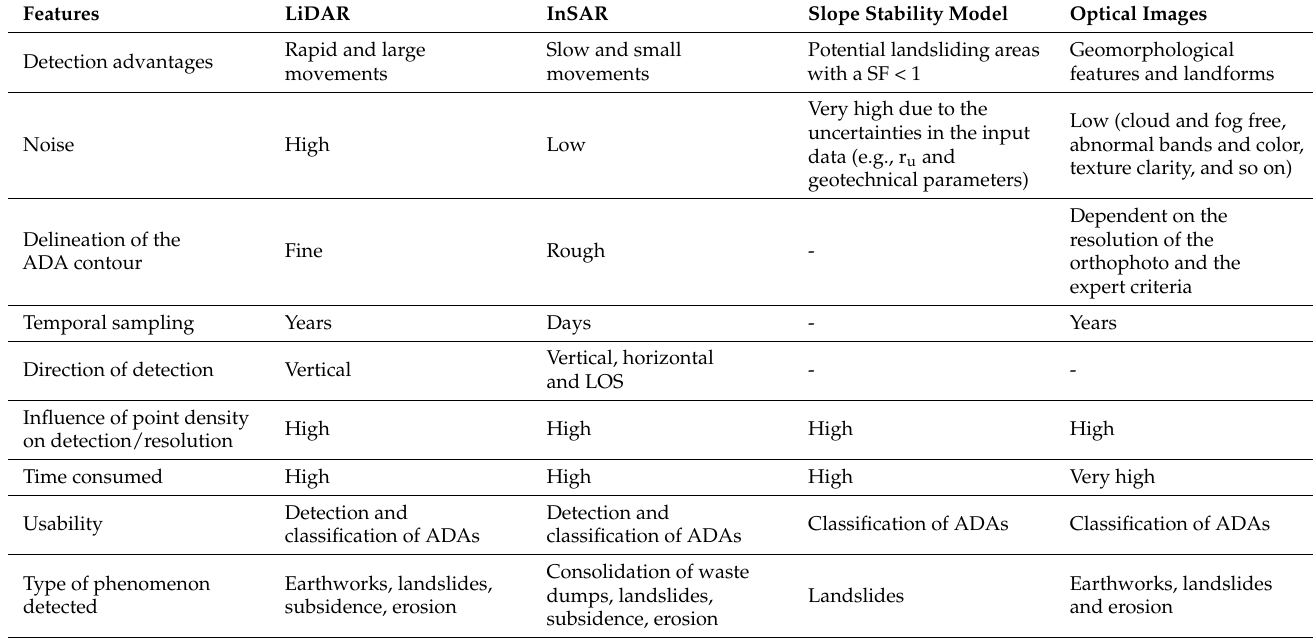
Table 7. Comparison of the main features of the different techniques used for the detection and classification of